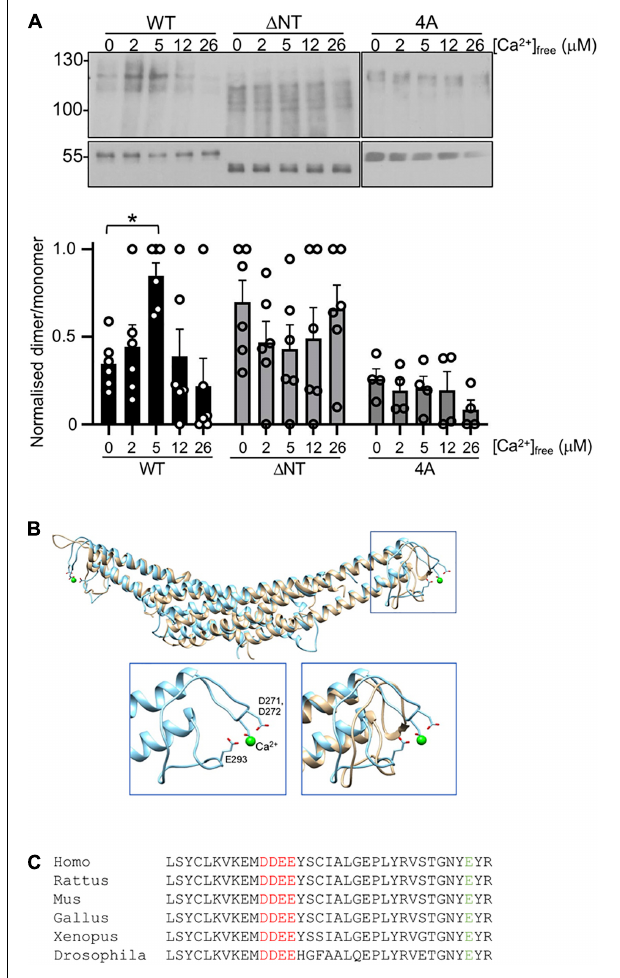
FIGURE 2 | Ca 2 + -dependent PICK1 dimerization is mediated by novel and established Ca 2 + -binding sites. (A) 100 nM his 6 WT-PICK1, his 6 (cid:49) NT-PICK1, or his 6 4A-PICK1 were incubated in a range of [Ca 2 + ] free (buffered with HEDTA) with 10 µ M DSS for 20 min. Protein was detected by Western blotting using anti-PICK1. Lower panels show monomers. Relative dimer to monomer band intensities were calculated. The graph shows dimer/monomer ratios, normalized to the highest value in each experiment N = 6, * p < 0.05. (B) Molecular modeling predicted that 271 DD 272 binds Ca 2 + . Final frames from 100 ns atomistic dynamic simulations demonstrate that 271 DD 272 , in conjunction with E 293 , binds a Ca 2 + ion (green sphere). The overlay of WT and 4A shows an intact BAR domain structure in 4A. Insets show the zoom of boxed section, WT-PICK1 alone (left), and WT overlayed with 4A-PICK1 (right). (C) Sequence alignment of PICK1 from Homo sapiens, Rattus norvegicus, Mus musculus, Xenopus laevis, and Drosophila melanogaster.